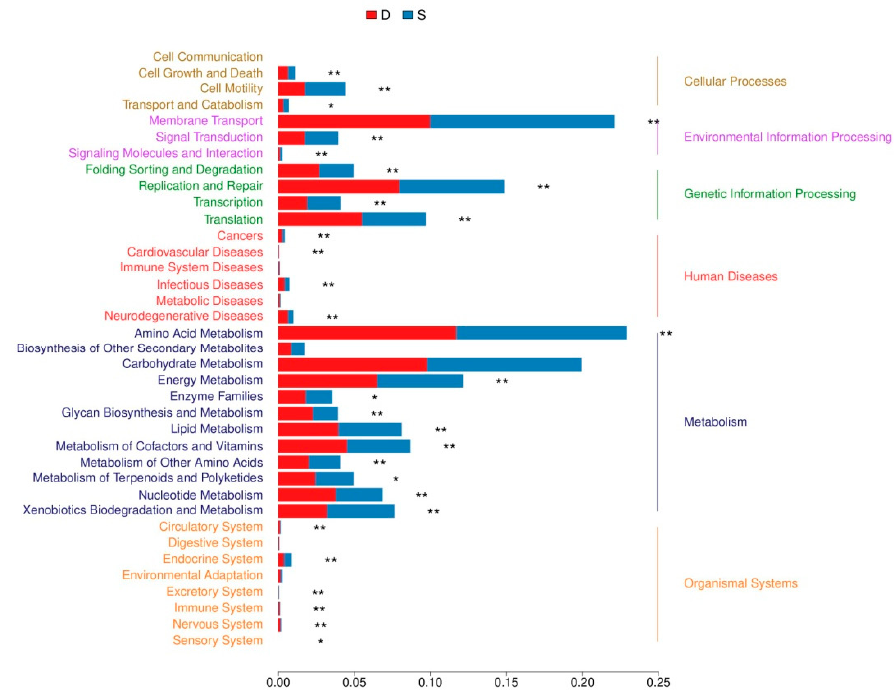
Figure 5. Relative abundance of KEGG functional pathways at Level 1 and Level 2 in coastal area S and D. Note: The left axis represents different KEGG metabolic pathways at Level 2, and the histogram with different colors represents the difference values of metabolic pathway of different groups. The right side lists six major categories of metabolic pathways at Level 1. * Indicates significant difference within the group ( p < 0.05); ** indicates significant difference within the group ( p <